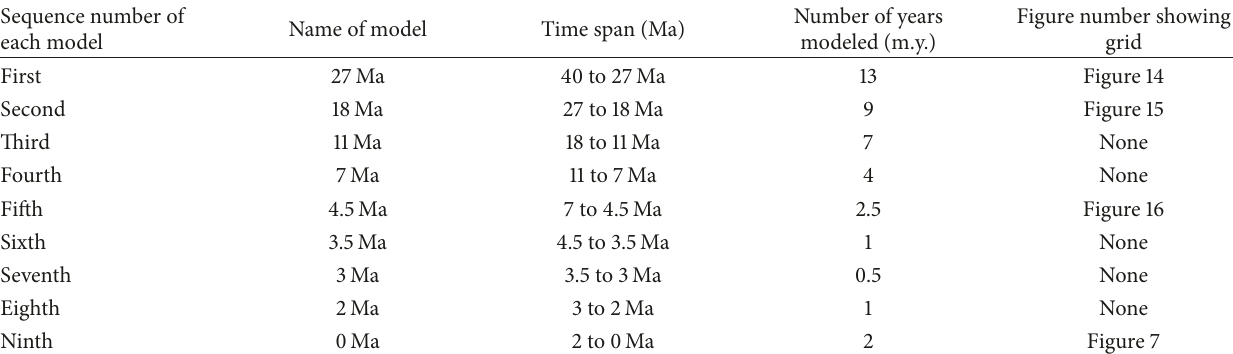
Table 3: The sequence of nine MODFLOW Models (m.y.: million